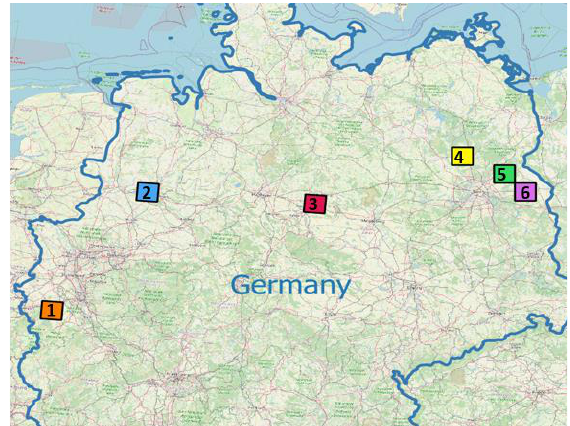
Figure 3. Location of the six areas in Germany used during the crop classification experiments. Red and Purple tiles are used for testing and the remaining four are used for the training phase.